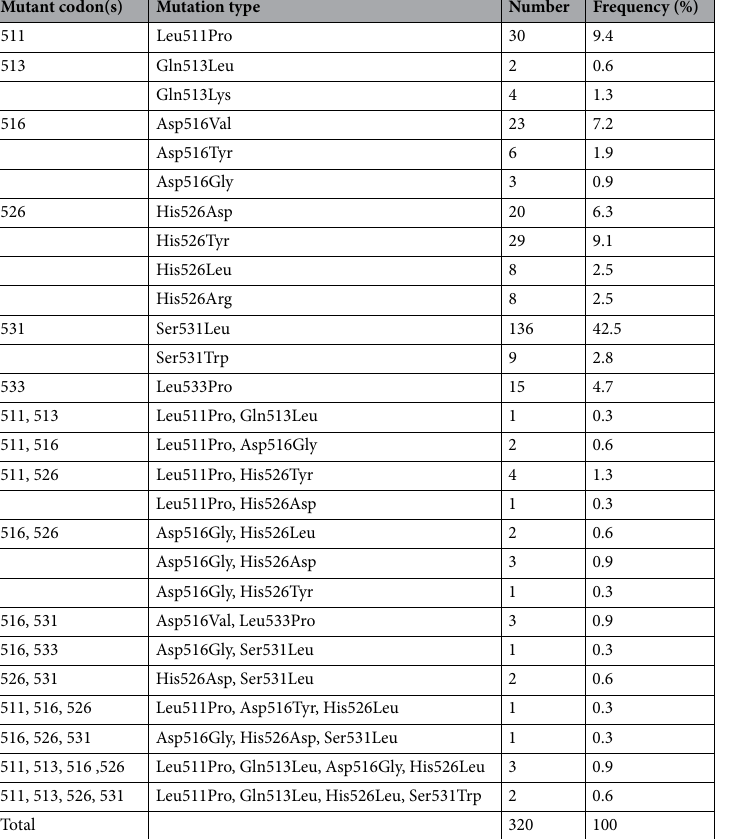
Table 2. The rpoB gene mutation of 320 RIF-resistant Mtb strains.